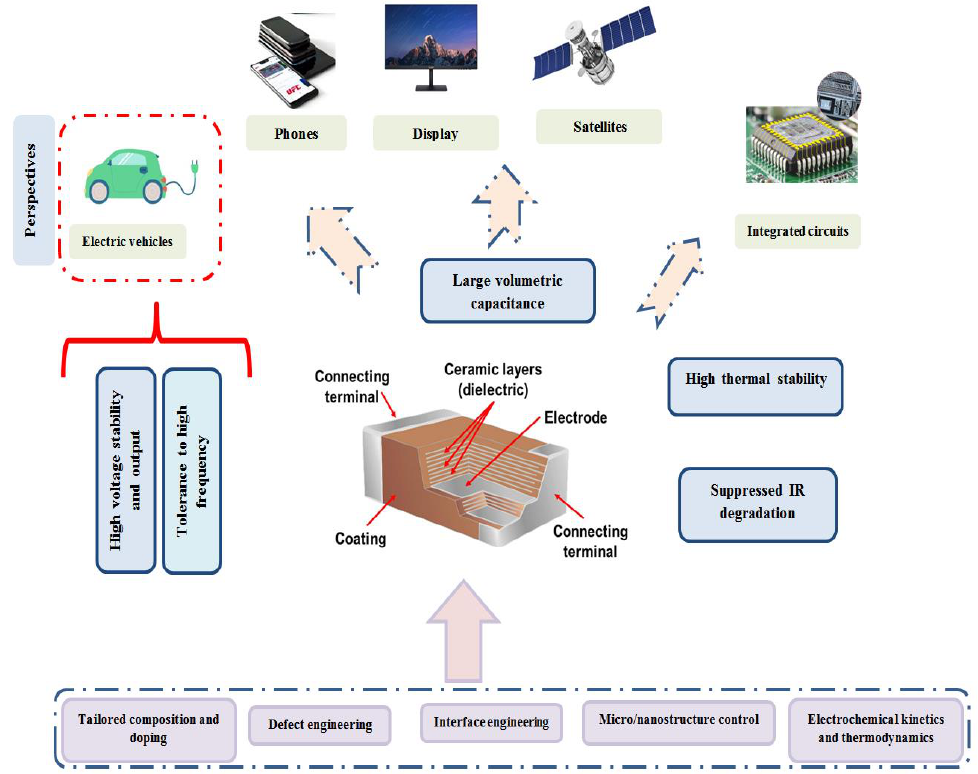
Figure 10. Diagram of MLCCs highlighting the main challenges in generating large, reliable MLCCs and their many applications.